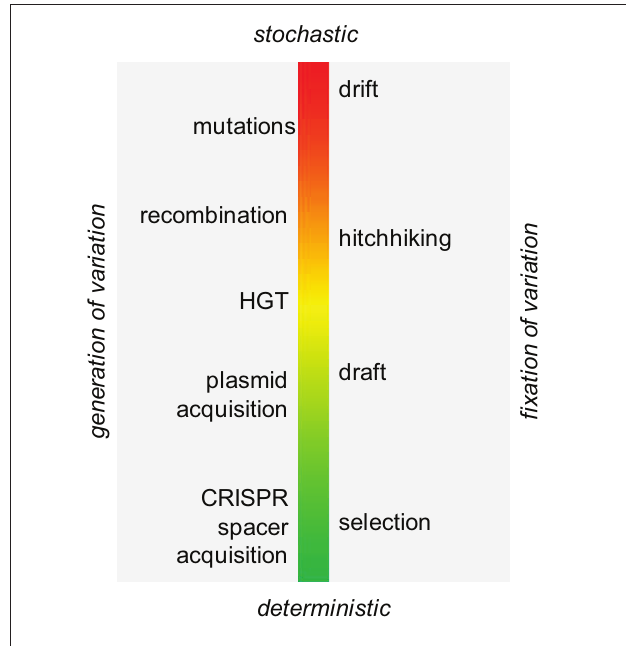
FIGURE 6 | The continuum of evolutionary processes, from stochasticity to